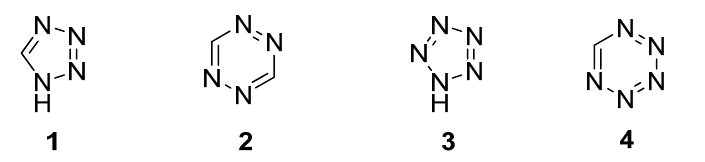
Figure 1. Structures of 1H -tetrazole ( 1 ), 1,2,4,5-tetrazine ( 2 ), 1H -pentazole ( 3 ) and pentazine ( 4